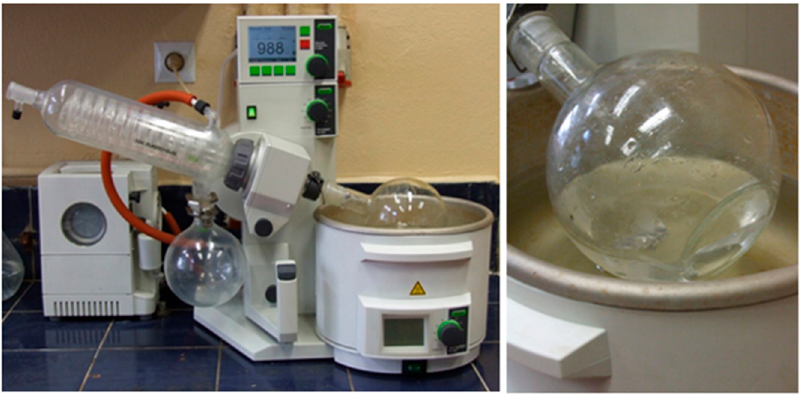
Figure 3. The rotary reactor driven by an evaporator (Buchi, Rotavapor R-210/215) used in the leaching experiments. Table 2. The parameters of leaching processes in solutions of H 2 SO 4 and HCl (RT = room temperature). Leaching Agent Leaching